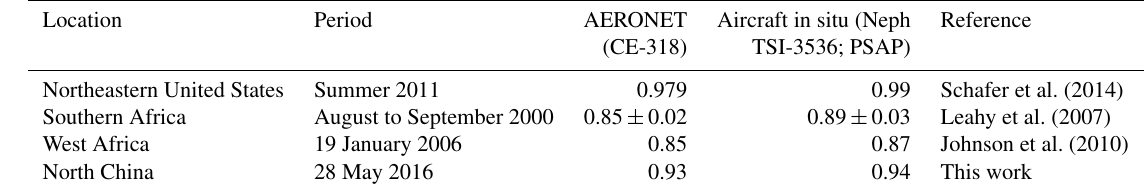
Table 3. Comparison of AERONET-retrieved and in situ aircraft-measured ω 550 from this and other studies. Location